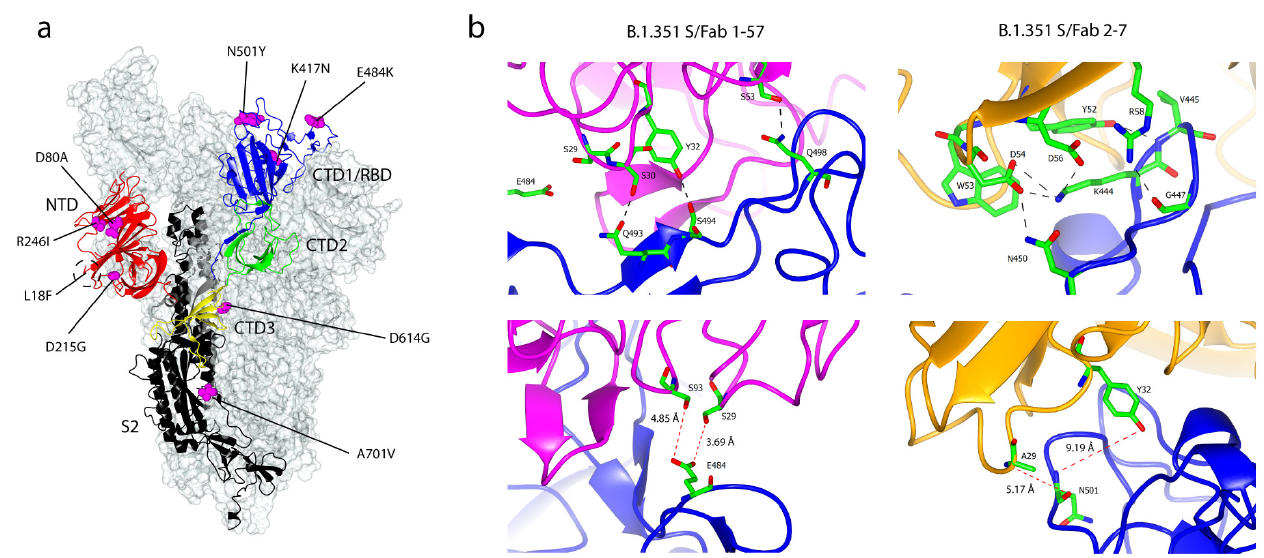
Figure 5. Mutations within the B.1.351 variant of SARS-CoV-2 S glycoprotein and recognition by Fab 1-57 and Fab 2-7. ( a ) The locations of nine substitution mutations on the structure of the South African B.1.351 SARS-CoV-2 S glycoprotein at 3.32 Å (PDB: 7LYN) [54]. Three mutations- K417N, E484K and N501Y- lie within the RBD. Four mutations- L18F, D80A, D215G and R246I- are in the NTD. There is no deletion mutation in the variant. ( b ) Left: recognition of CDR-L1 and CDR-L2 of the Fab 1-57 (magenta) on the RBD (blue). Residues that are involved in binding are labelled. Hydrogen bonds are represented as black dash lines (less than 3.2 Å). E484 did not interact with any residues as it is too distant from S29, S93 and V100 (not shown). The distances of E484 to S29 and S93 are 3.69 Å and 4.85 Å, respectively (PDB: 7LS9) [61]. Right: recognition of CDR H2 from Fab 2-7 (orange) of the RBD (blue). Residues that are involved in binding are labelled. Hydrogen bonds are represented as black dash lines. N501 did not interact with any residues on Fab 2-7. The distances of N501 to A29 and Y32 are 5.17 Å and 9.19 Å, respectively—too distant for the formation of hydrogen bonds (PDB: 7LSS)